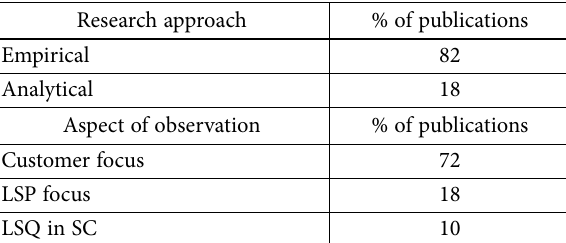
Table 2. Distribution of papers by research approach and focuses in LSQ